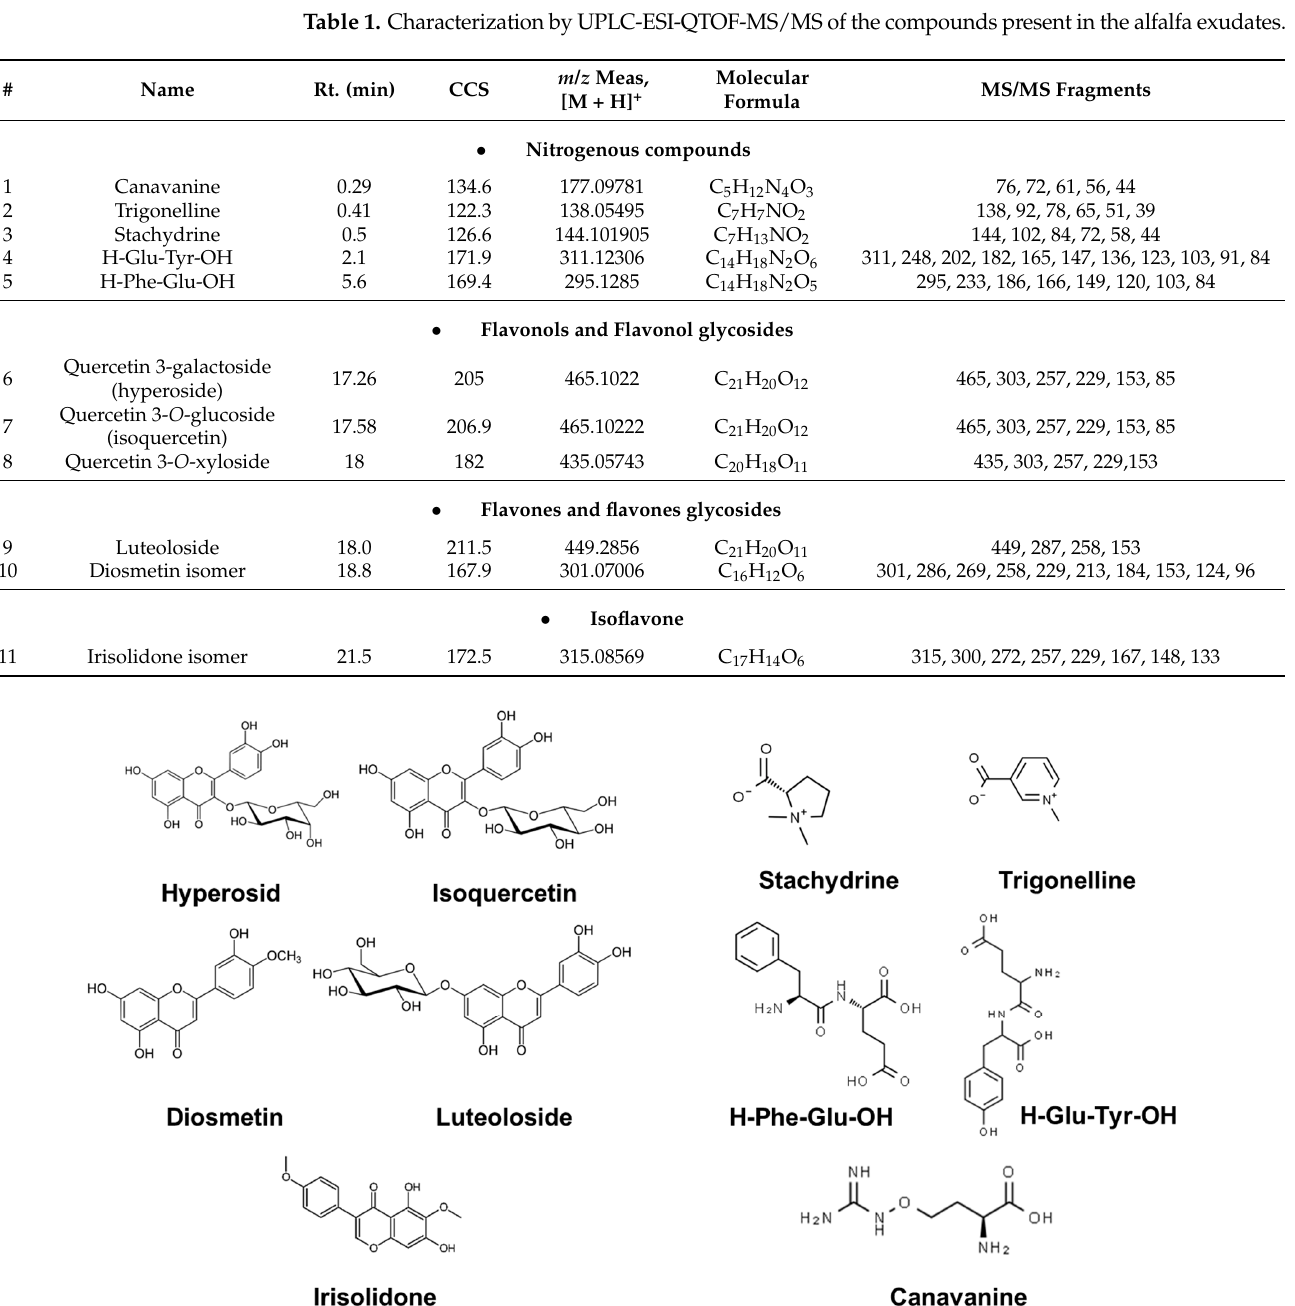
Figure 4. Structure of the main compounds identified through LC–MS/MS in negative mode and positive ESI ion mode.